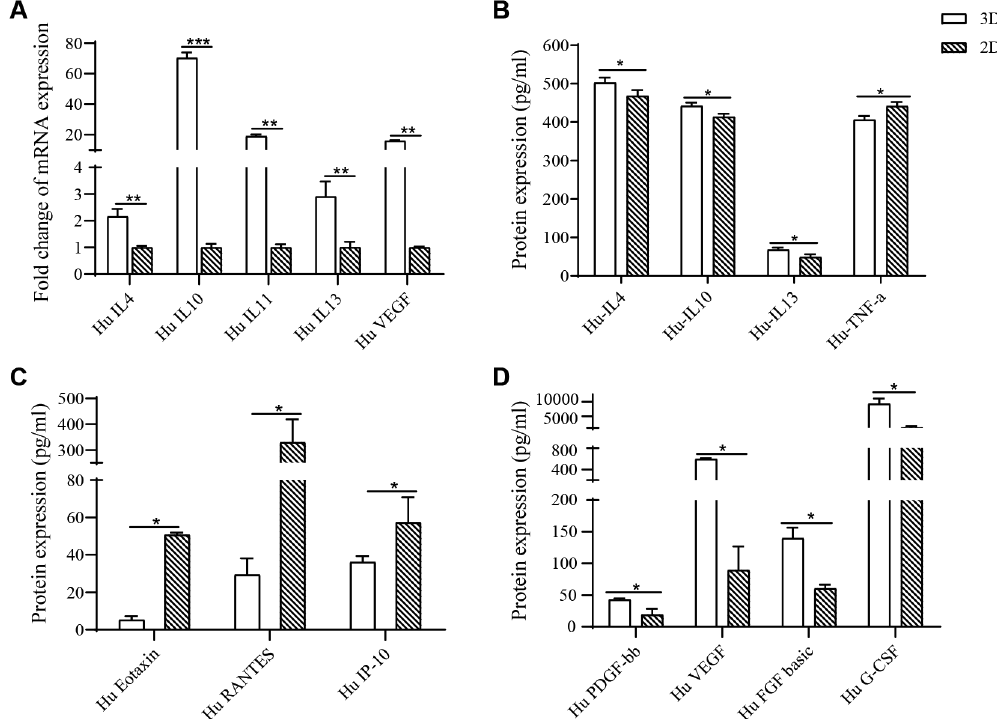
Fig. 2 HPMSCs expression pro fi le of cytokines. A The analysis of MSC-secreted cytokines in terms of in fl ammation (IL-4, IL-10, IL-11 and IL- 13) and angiogenesis (VEGF) through RT-PCR. B 3D-HPMSCs promoted the secretion of anti-in fl ammatory factors (IL-4, IL-10, and IL-13), and inhibited pro-in fl ammatory factor TNF-a secretion compared with 2D-HPMSCs. C 3D-HPMSCs inhibited the secretion of chemokine (Eotaxin, Rantes, and IP-10) compared to 2D-HPMSCs. D 3D-HPMSCs also contributed to the secretion of trophic factors (PDGF-bb, VEGF, FGF basic, and G-CSF). B Enzyme-linked immunosorbent assay, C , D Bio-Plex ProTM cytokine assay, ∗ , ∗∗ , and ∗∗∗ indicate P < 0.05, P < 0.01, and P < 0.001,